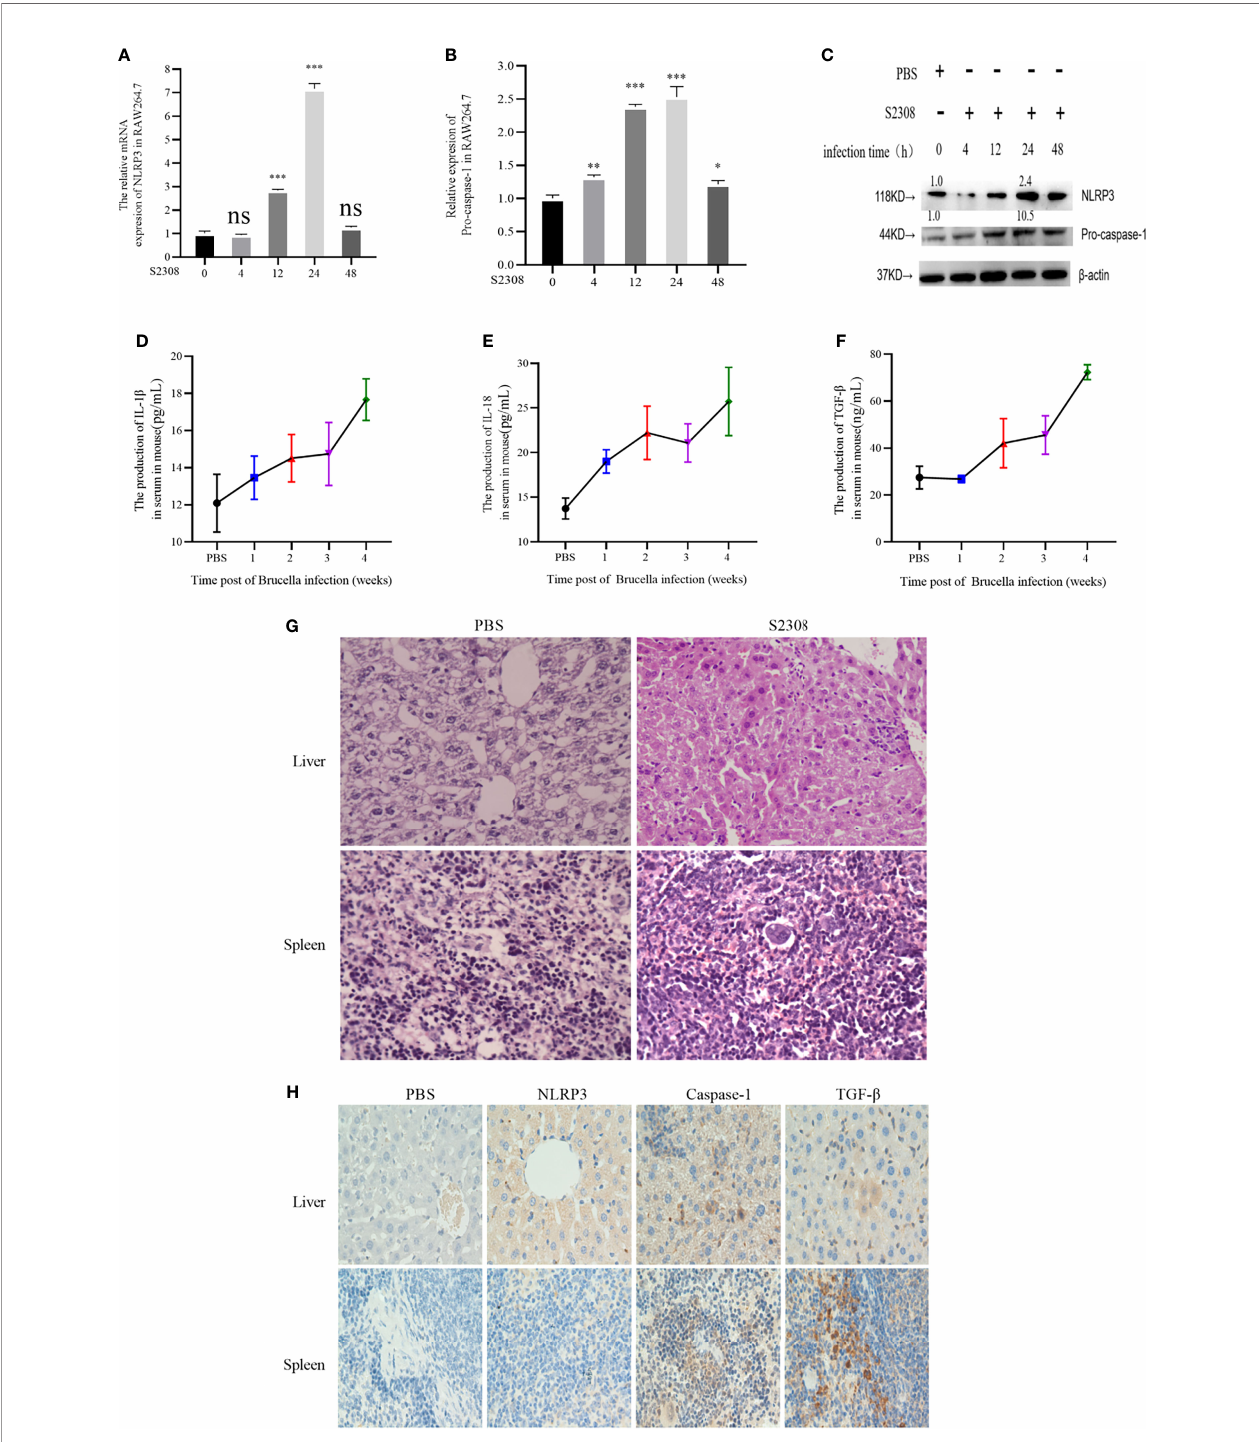
FIGURE 1 | Brucella infection-induces an in fl ammatory response in vitro and vivo . (A, B) The mRNA expression of NLRP3 and Pro-caspase-1 in RAW264.7 cells infected with at 4, 12, 24, and 48 h of S2308 infection using qRT-PCR. (C) Protein expression of NLRP3 and Pro-caspase-1 assessed by western blotting. (D – F) Expression levels of IL-1 b , IL-18 and TGF- b in the blood serum of mice infected by S2308, as detected by ELISA. (G) Representative H&E-stained liver and spleen issues of Brucella -infected mice. Bar, 80 µm. (H) Representative immunohistochemistry of NLRP3 and caspase-1 levels in liver and spleen of Brucella -infected mice. Bar 100µm. Data are shown as mean ± SD (n = 3). *p < 0.05, **p < 0.01, ***p < 0.001, one-tailed t-test. ns, not signi fi